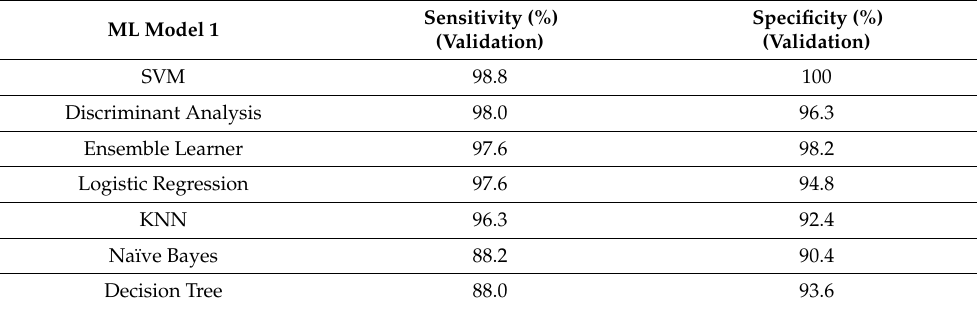
Table 6. Results of the stumble detection problem (validation).